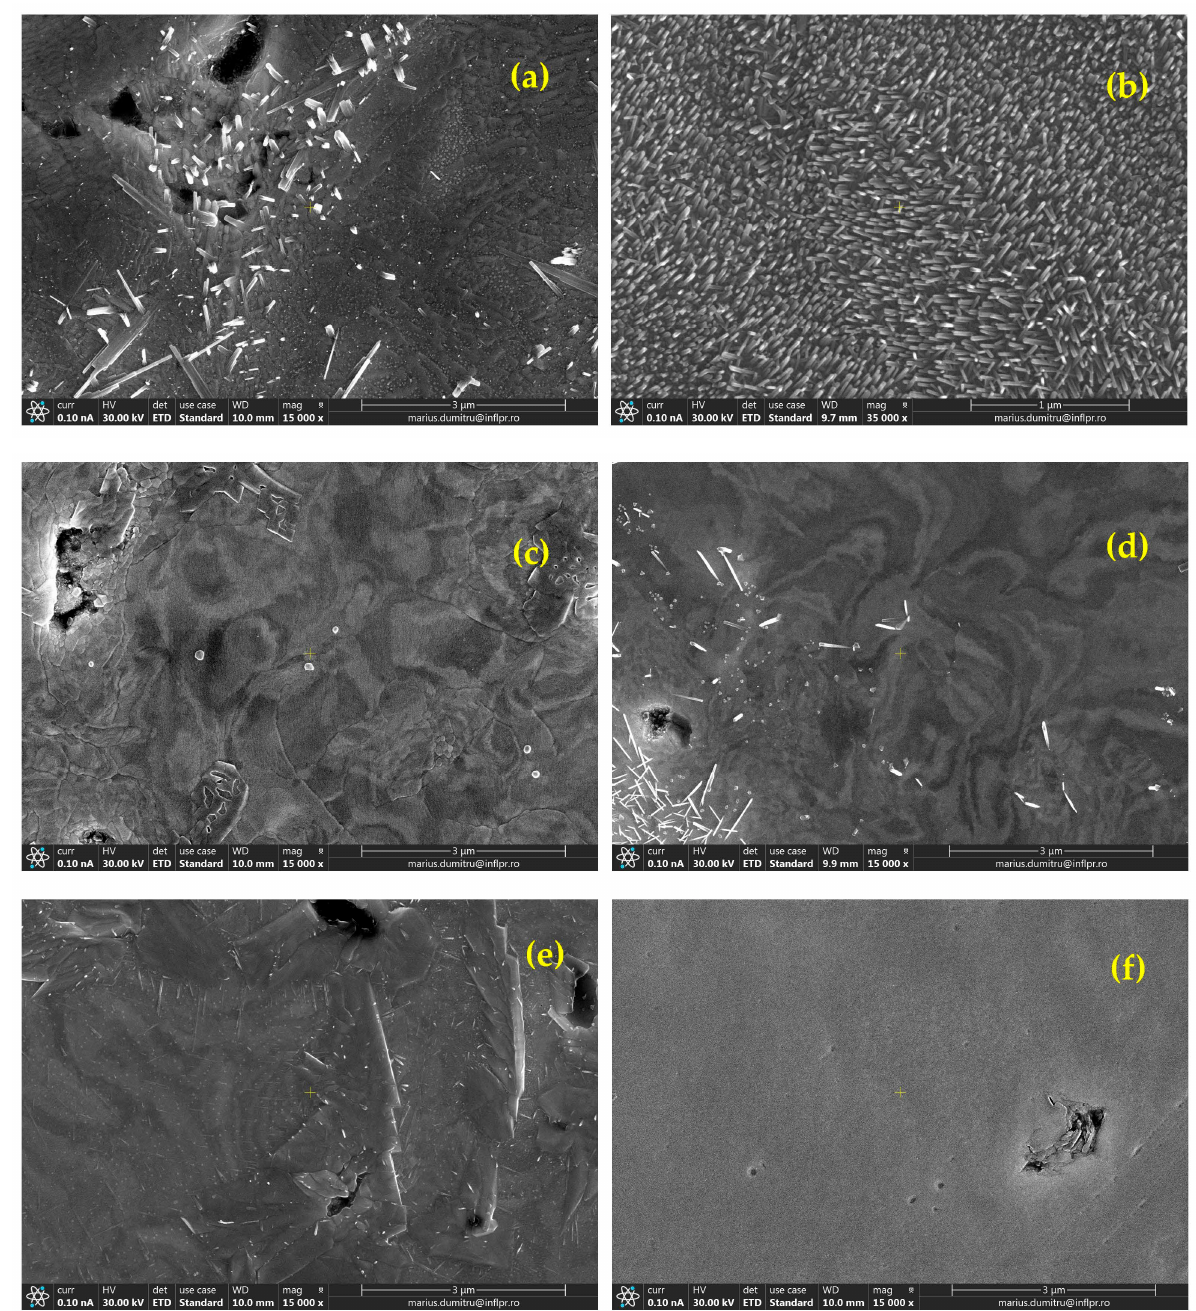
Figure 11. SEM images, obtained using a secondary electron detector, of the exposed surfaces of different W-ceramic materials after 6 MeV electron irradiation: ( a ) W-SiC 0.2%, ( b ) W-SiC 0.4%, ( c ) W-diamond 0.2%, ( d ) W-diamond 0.4%, ( e ) W-ZrC 0.5% and ( f ) W-ZrC 0.6.